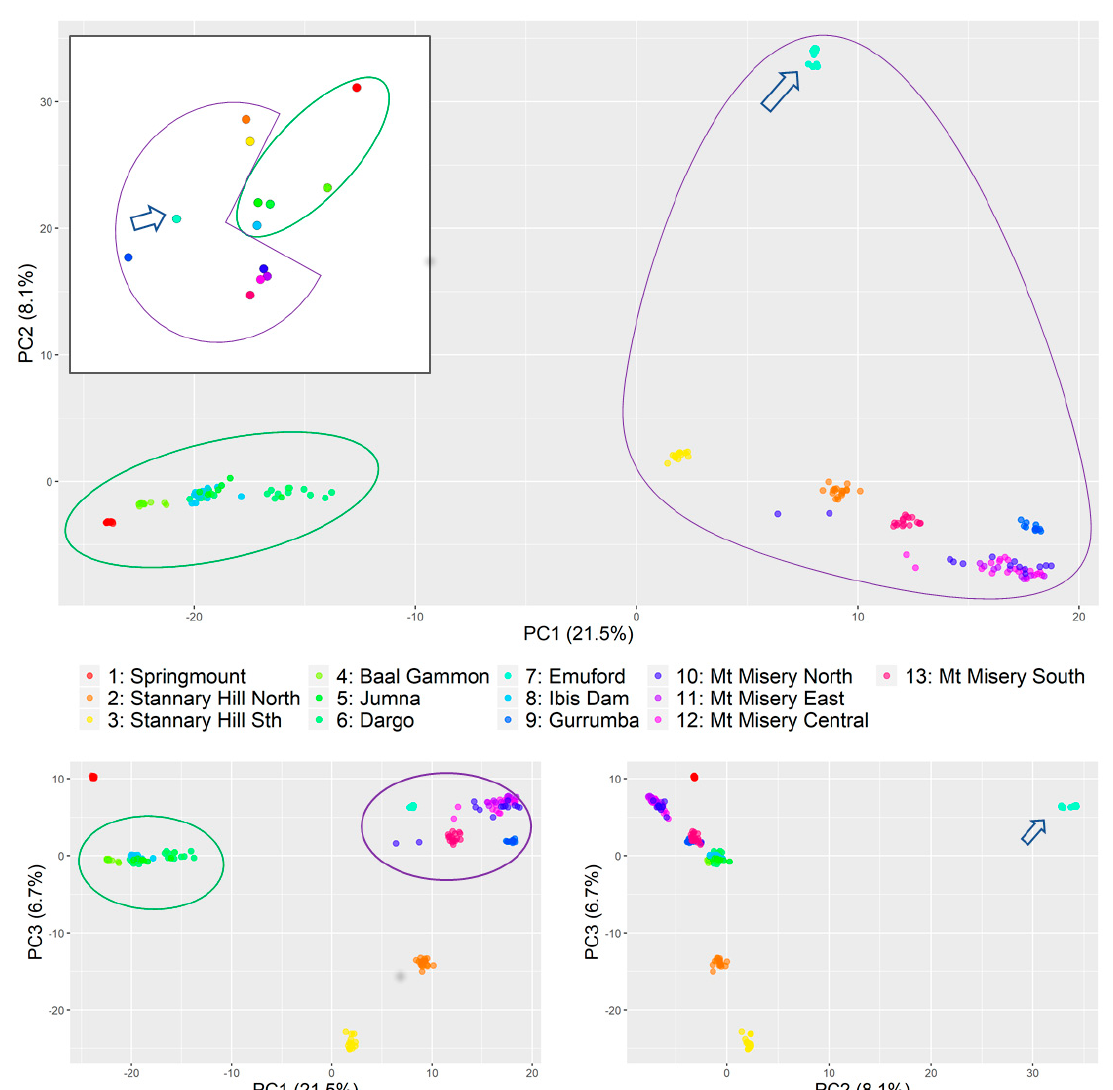
Figure 2. Three plots illustrating the relationships amongst individuals of Acacia purpureopetala inferred from principal components analysis based on SNP data. PC1 vs PC2 (top), PC1 vs PC3 (bottom left), and PC2 vs PC3 (bottom right). The percentage variation explained by each component is provided along the X and Y axis. PC1 separated two large clusters (indicated with purple and green shapes) while all samples from Emuford separated from these clusters along PC2 (blue arrow). The samples from Stannary Hill South (yellow dots) and North (orange dots) and Springmount (red dots) were further separated into distinct groups along PC 3. Samples from each field site are colour coded in the same colours used in Figure 1 and the relative geographic locations of the field sites are illustrated in the insert (top left corner).